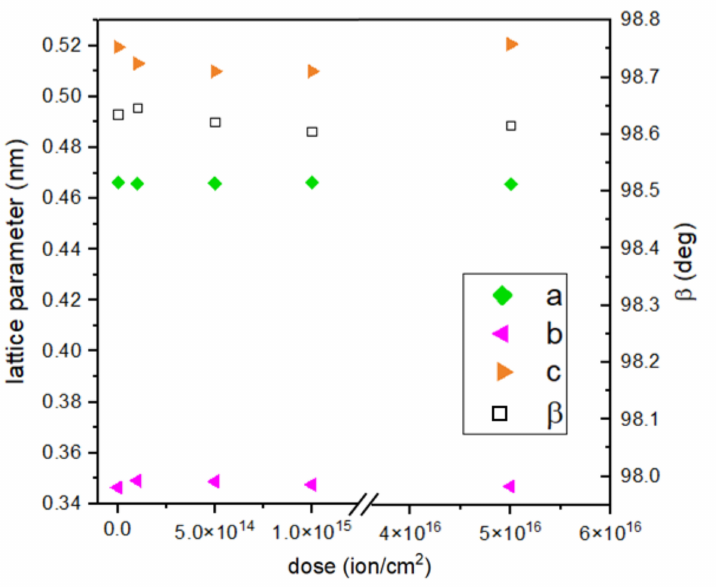
Figure 5. Calculated lattice parameters of CuO in dependence on dose of